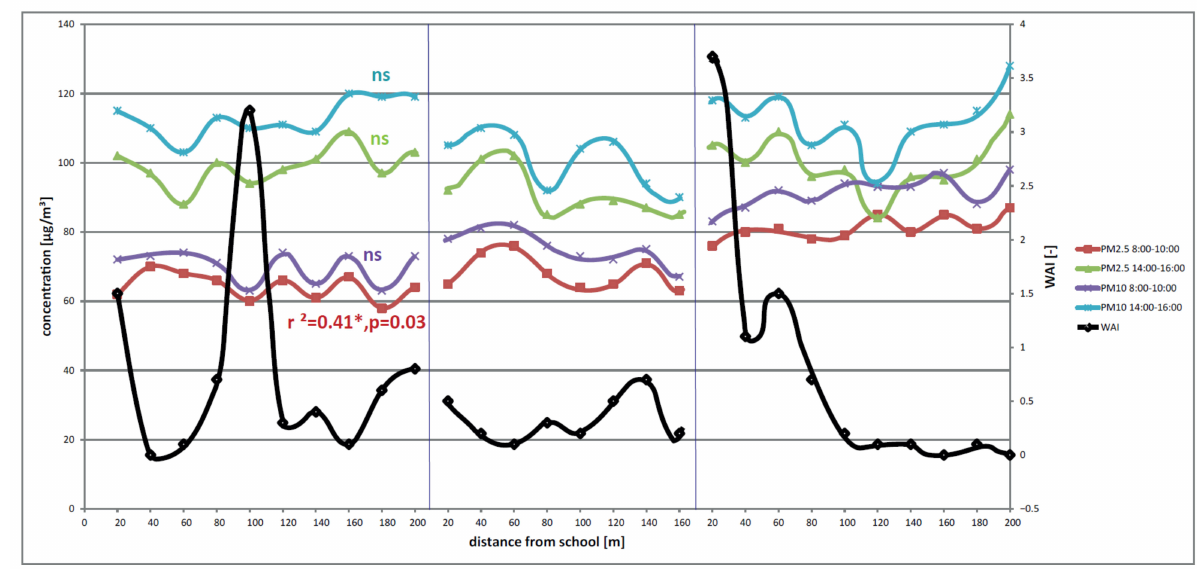
Figure 7. WAI distribution and an average PM concentration from 8:00 to 10:00 and from 14:00 to 16:00 in study plots along walking paths to school D (low share of trees, high number of local heating emission sources). ns—no